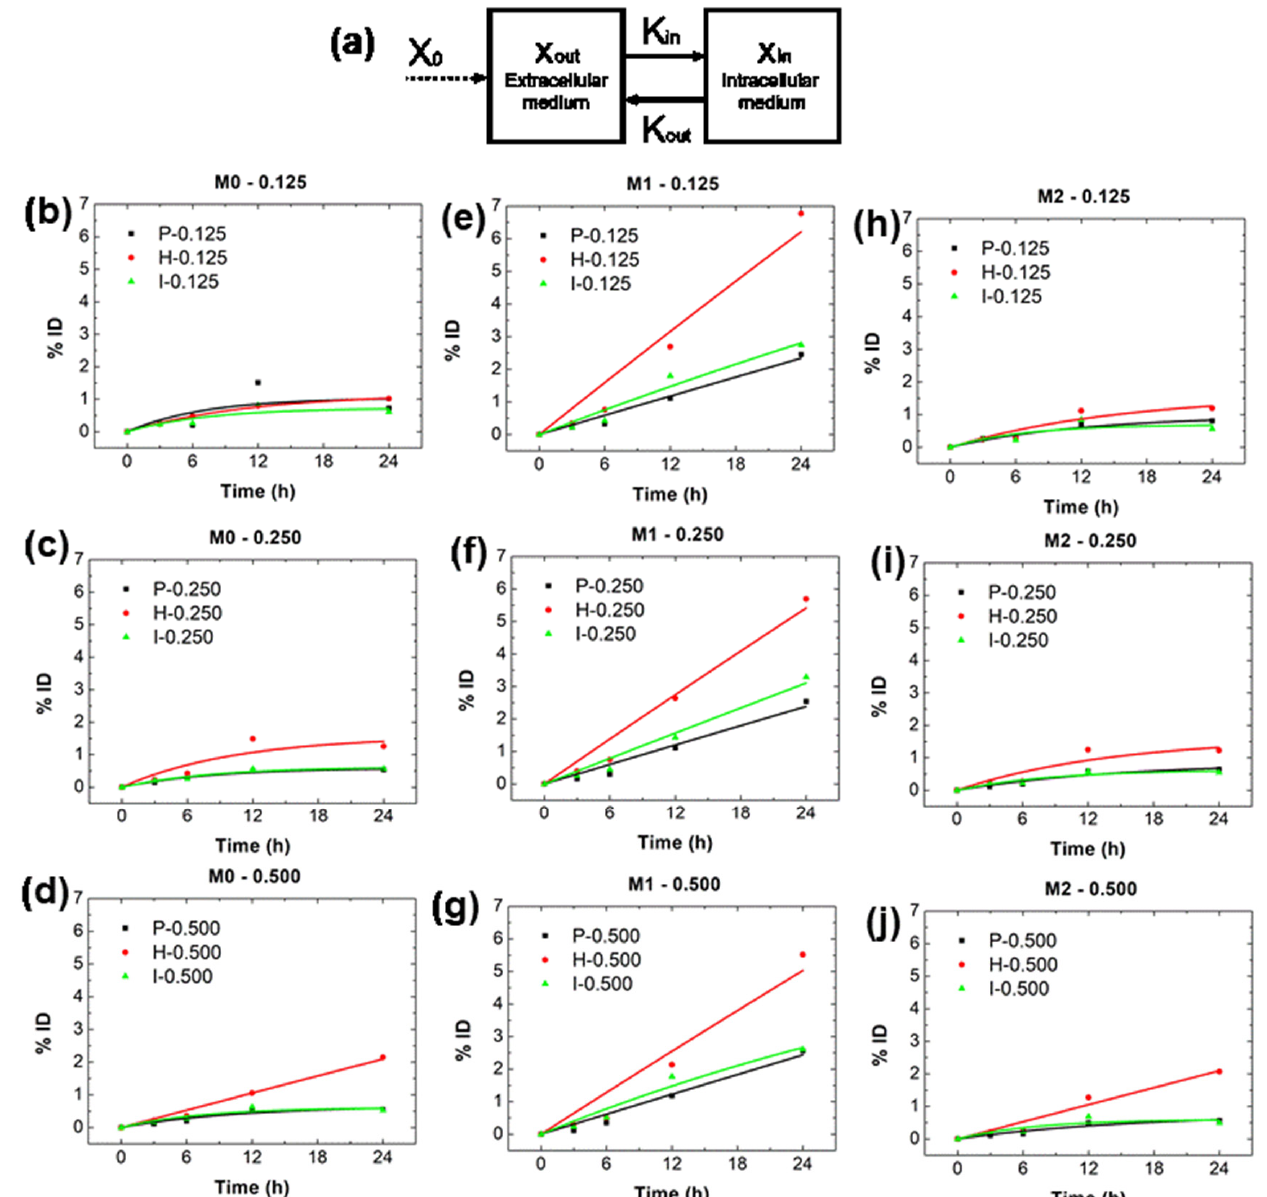
Figure 2. Two-compartment model results using data obtained from in vitro cell-internalization experiments with macrophages. ( a ) Two-compartment model used to determine the rate constants K in and K out , i.e., to model the macrophage internalization kinetics in vitro. ( b – j ) Fitting to mean values obtained from in vitro cell-internalization experiments with macrophages. Fitting of the macrophage internalization kinetics x in ( t ) was conducted by weighted least squares fitting using Equation (17) to the in vitro mean experimental values (ferene-s assay at 3, 6, 12, and 24 h) described above. RAW264.7 murine macrophage cells were incubated with one of three different BNF initial concentrations (0.125, 0.250, or 0.500 mg of Fe) and three different BNF configurations (P = BNF-Plain, black lines, no antibodies; H = BNF-Her, red lines; and I = BNF-IgG, green lines) as described. ( b – d ) Results for nonpolarized macrophages, M0. ( e – g ) Results for M1 macrophages. ( h – j ) And, results for M2 macrophages (values obtained using complete data set are provided in Supplementary Infor- mation). Table 2. Values of 𝑲 𝒊𝒏 and 𝑲 𝒐𝒖𝒕 obtained from the fitting shown in Figure 2 for BNF-plain using mean values.